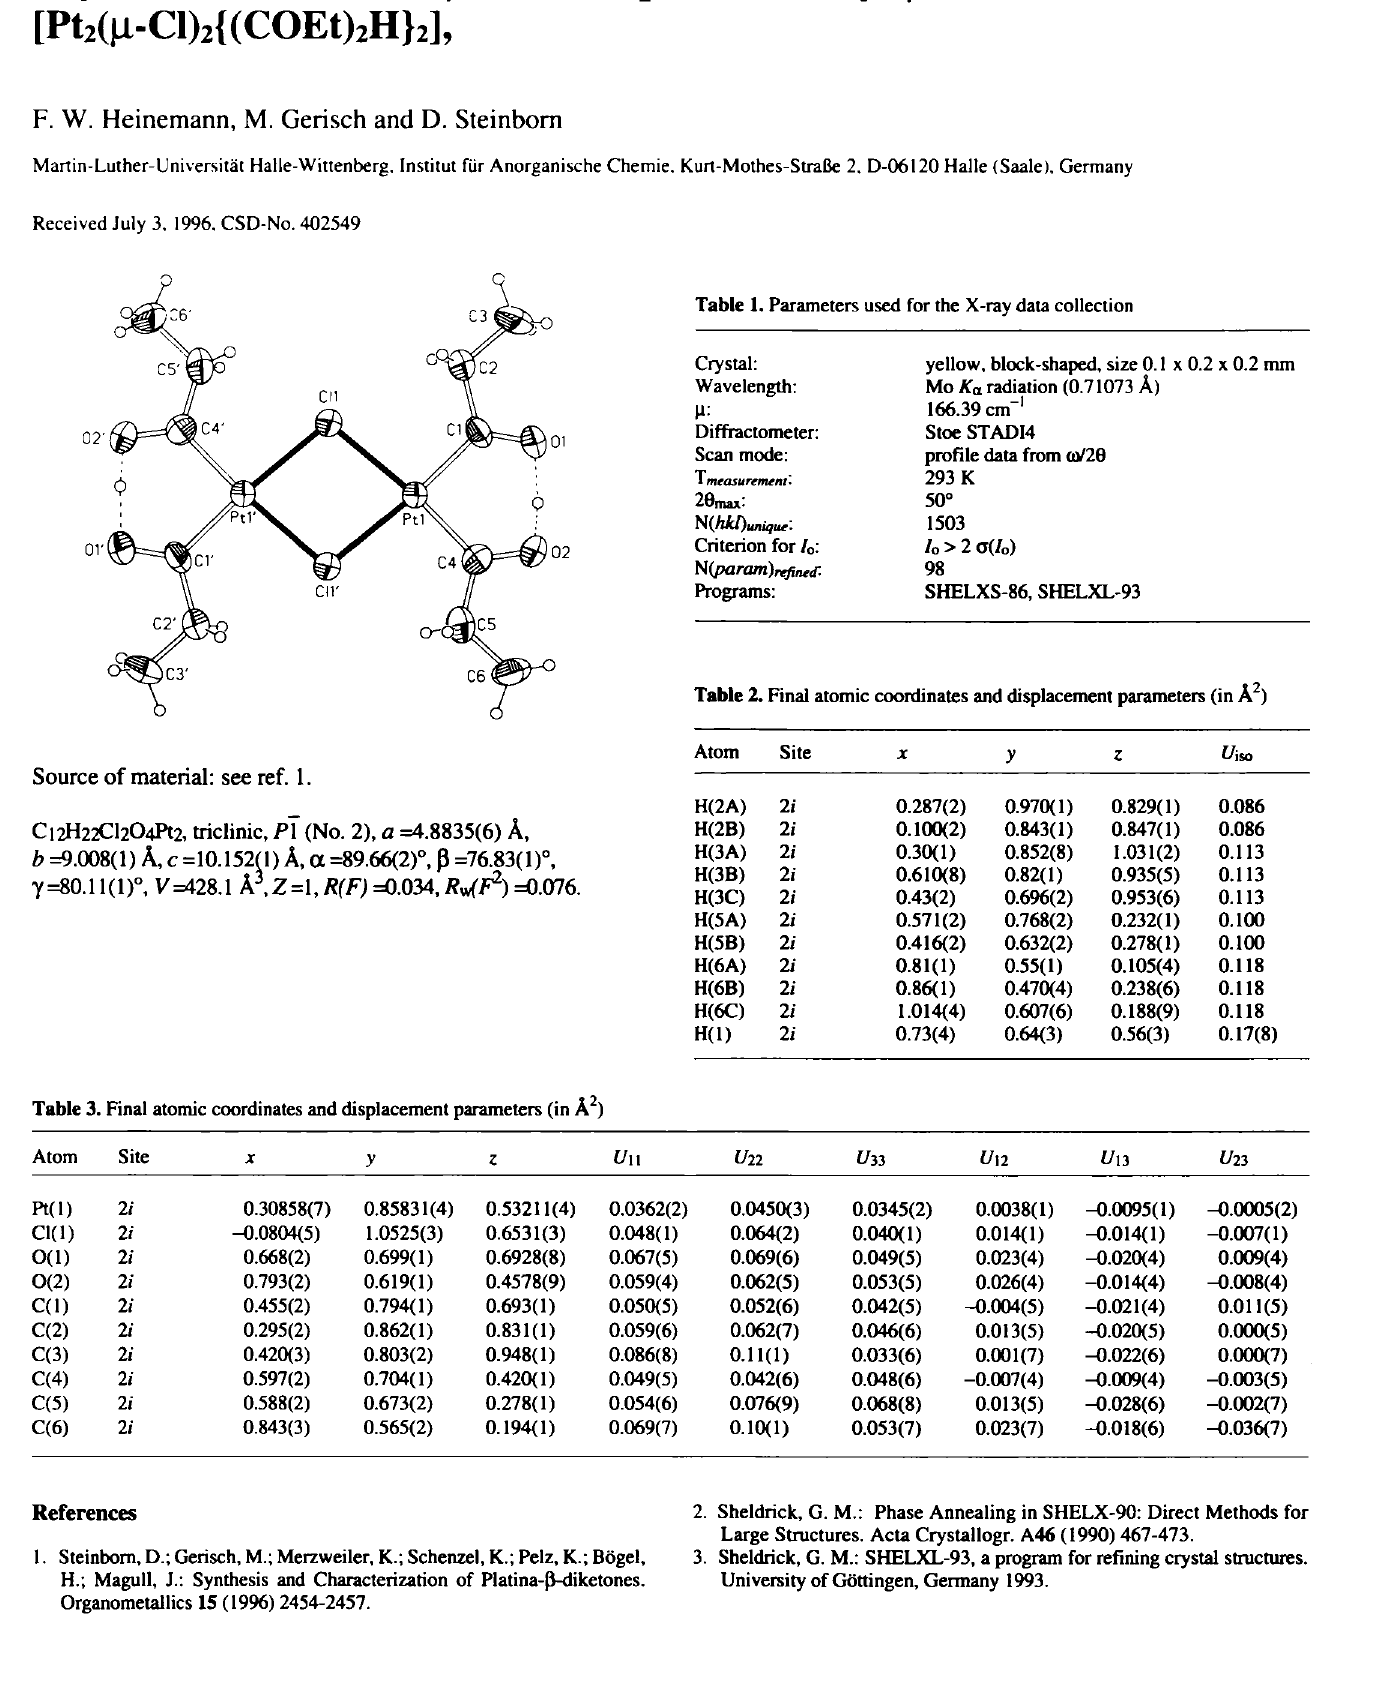
Table 2. Final atomic coordinates and displacement parameters (in Â 2 )